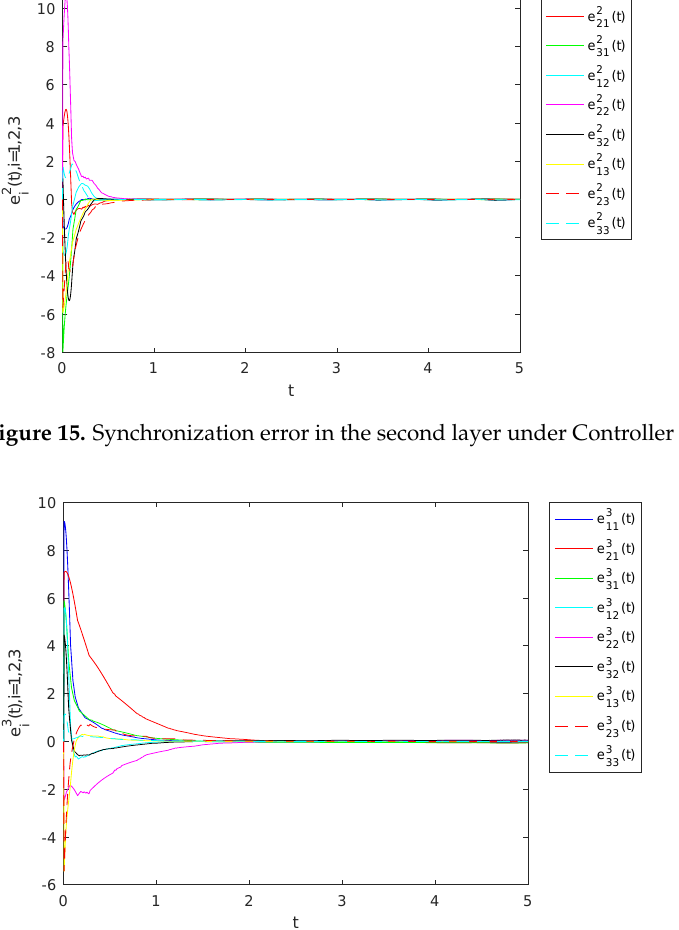
Figure 16. Synchronization error in the third layer under Controller